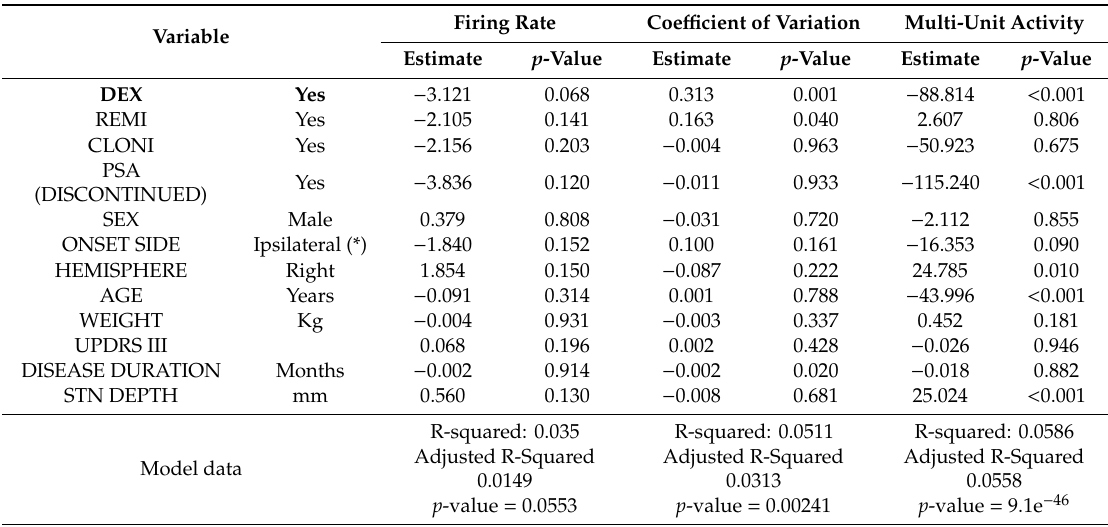
Table 2. Standard linear regression model for firing rate, CV and MUA.